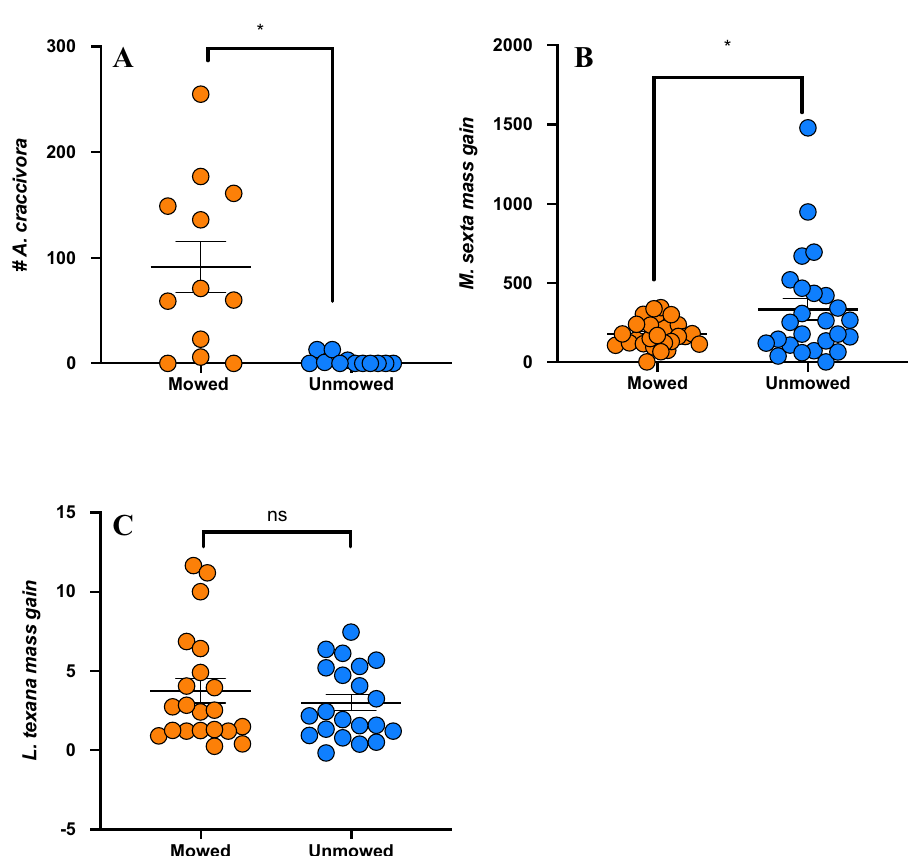
Figure 5. Results of herbivory in lab results from 3 herbivores ( A ) number of A. craccivora (Y-axis) (P < 0.001; Poisson distribution fit model regression), ( B ) mass gain of M. sexta caterpillars (Y-axis) (P = 0.022; Kruskal– Wallis test) and ( C ) mass gain of L. texana (Y-axis) on mowed (orange bar) and unmowed (blue bar) plants (P = 0.715; Kruskal–Wallis test). Means are shown by scale bars and asterisk denotes significantly different results at p < 0.05, while ns denotes non-significant